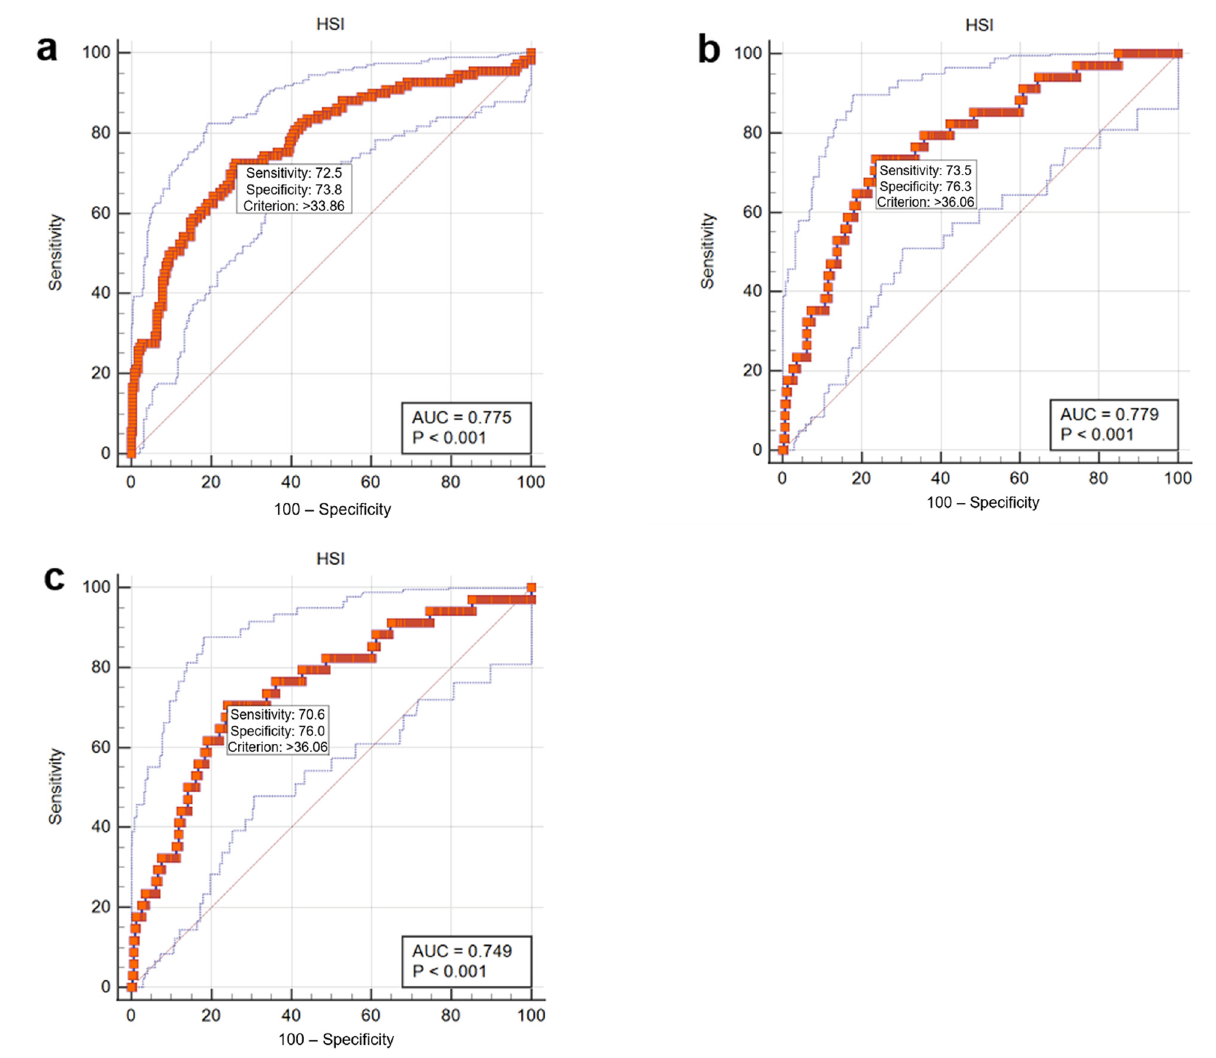
Figure 4. Receiver operating characteristics curves showing the performance of HSI in the diagnosis of hepatic steatosis using CT criteria ( a – c ).